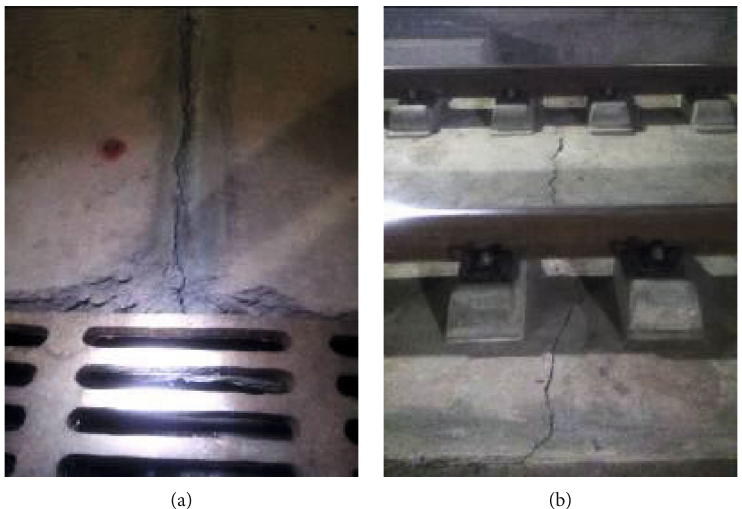
Figure 1: Tunnel cracks: (a) longitudinal and (b) transverse.